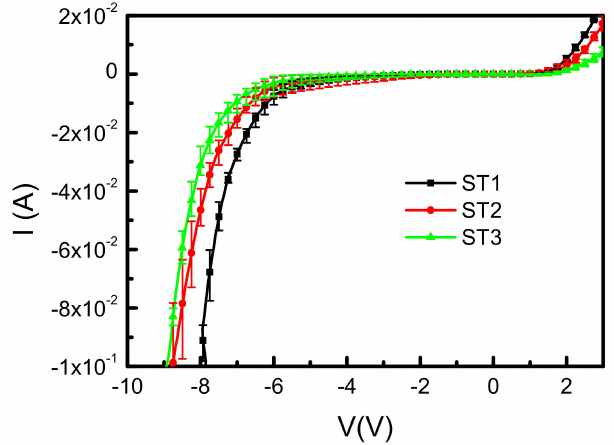
Figure 5. Current-voltage (I-V) characteristics of samples ST1, ST2, and ST3 measured at room temperature. Table 1. The diode ideality factor (n) and series resistance (Rs) of the p-Si/MgZnO:Er/ZnO:In